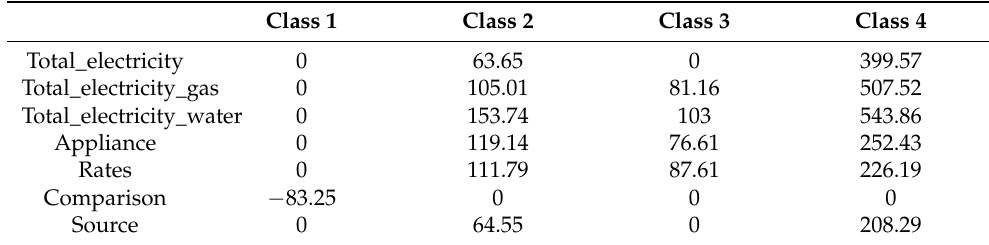
Table 6. WTP for the latent class models